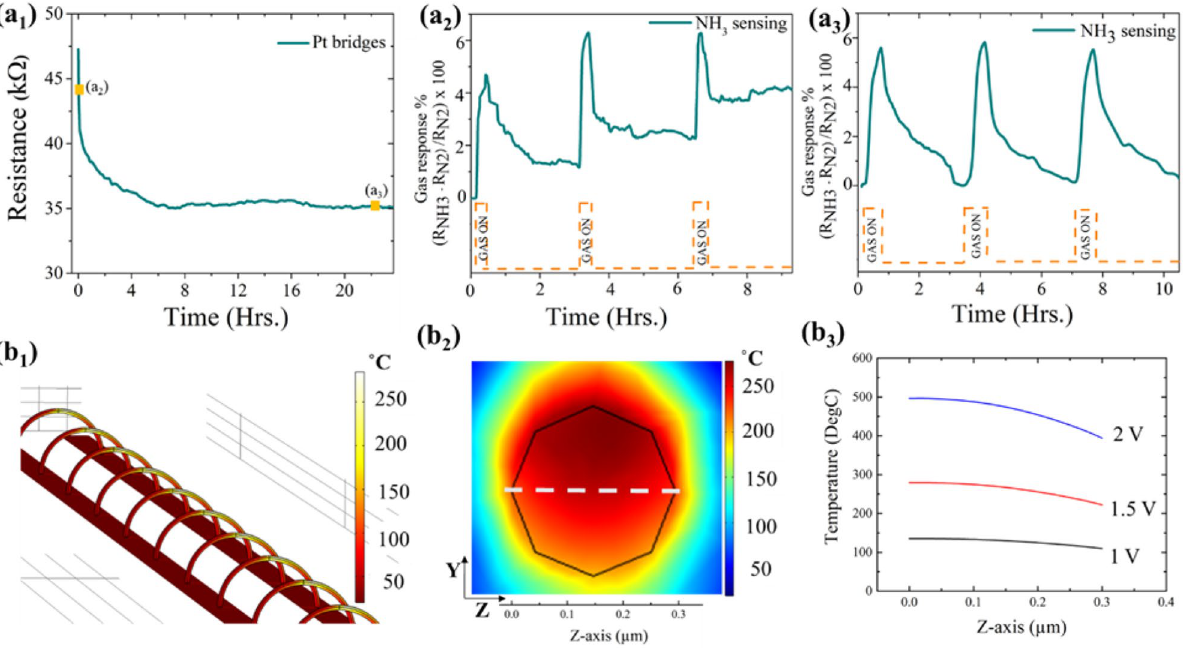
Figure 5. Gas sensor preconditioning and Joule heating simulations. Gas-sensitive bridges need to be placed in a constant flow of background gas for ~ 24 h to stabilize the gas sensor response. ( a 1 ) Pt sensing bridges decrease their overall bridge resistance during the preconditioning cycle. After this step, the bridge resistance is stable over time and hence is expected to reach stationary state with ambient conditions of temperature and gas species. If the NH 3 response test starts without preconditioning, we obtain a sensor drift as shown in ( a 2 ), which decreased by over 80% after stabilization in ( a 3 ). ( b ) COMSOL Multiphysics simulations of the temperature of Pt nanoparticle-based bridges due to Joule heating at an external bias of 1 V, 1.5 V, and 2 V in 1 slm N 2 flow are shown. It is assumed that the array of bridges ( b 1 ) is composed out of solid Pt nanowires with a 0.3 µm cross-section which is represented by a black polygon in ( b 2 ) where the temperature profile is shown as a heat map for an external bias of 1.5 V. This temperature profile is plotted as a function of position (white dashed